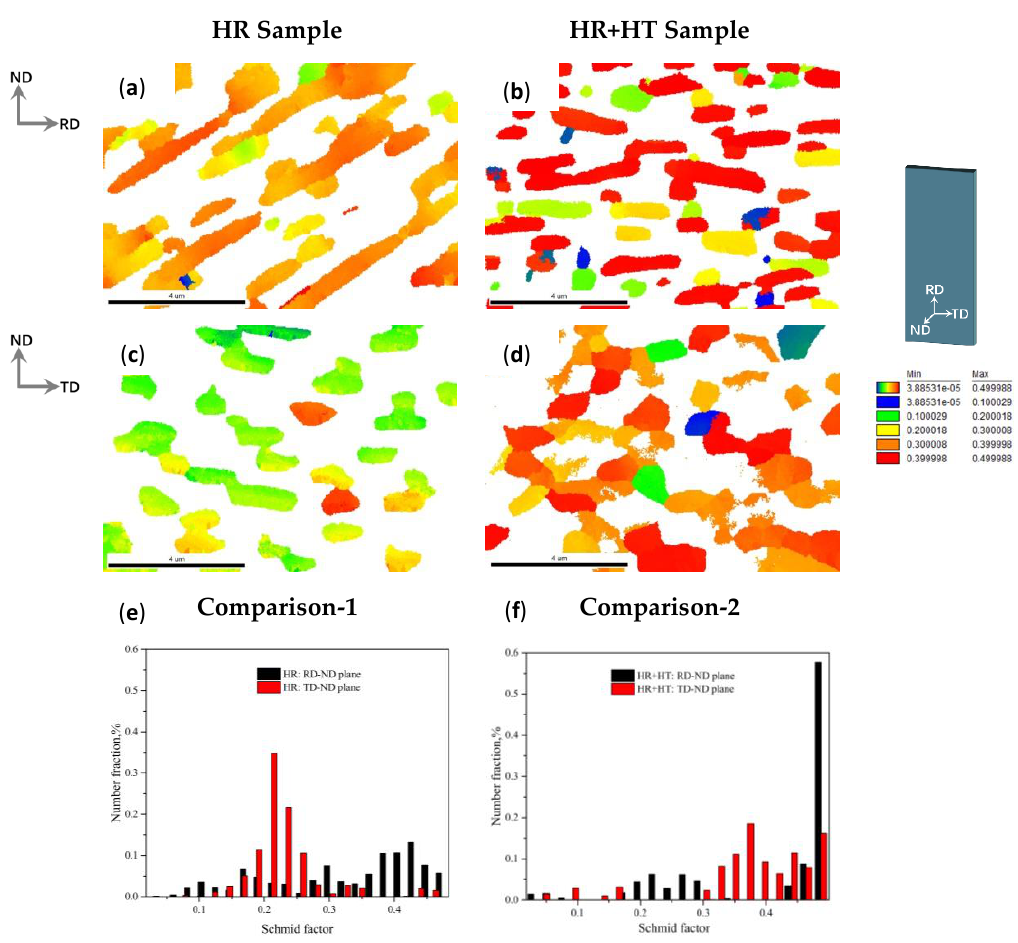
Figure 7. Schmid factor distributions of {10-10}<1-210> slip system in α phase. ( a , b ): ND-RD plane; ( c , d ): ND-TD plane; ( e ): comparison of ( a ) and ( c ); ( f ): comparison of ( b ) and ( d ). Compared with those of α phase, the SF distributions of {110}<1-11> slip system in the β phase of HR and HR+HT samples are both relatively centralized. As for the HR sample, the SF values in ND-RD plane are slightly lower than those in the ND-TD plane. After HR+HT, the increased SF values in ND-RD plane and decreased SF values in ND-TD plane are observed, which result in the inverse phenomenon to that in the HR sample. But the SF values are still relatively high.